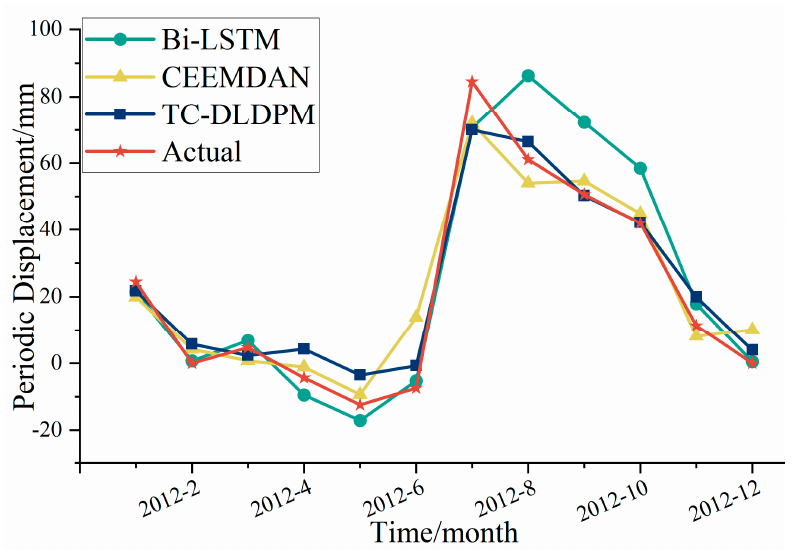
Figure 20. Comparison of the prediction results of the periodic term displacement by different mod- els.